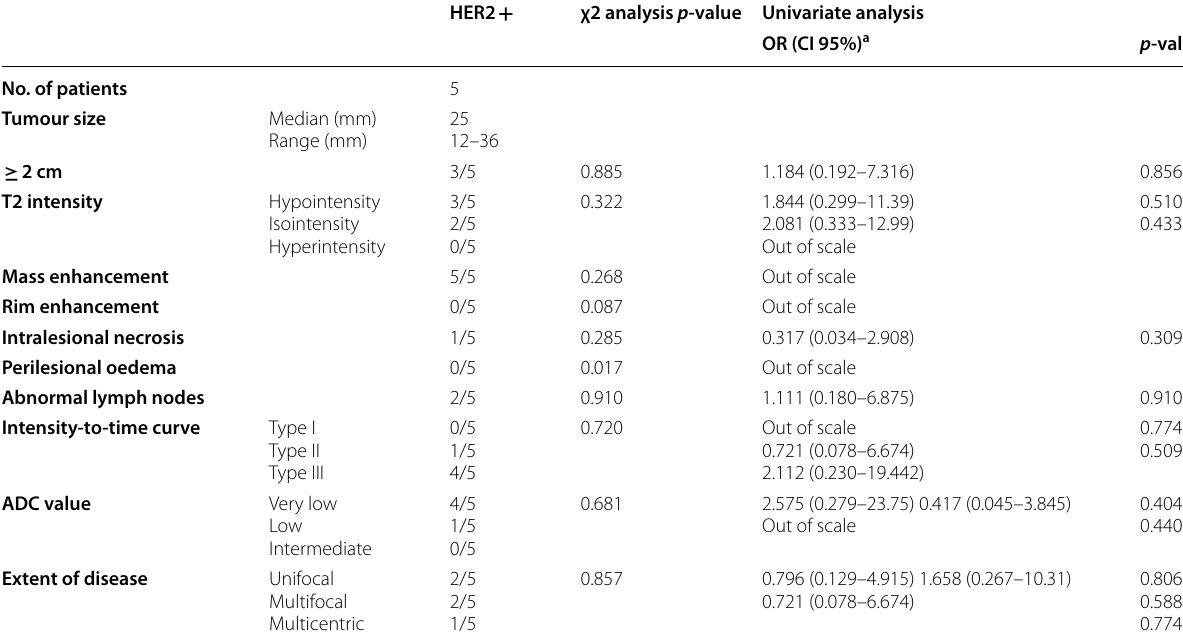
a OR Odds ratio, CI Confidence interval, ADC Apparent diffusion coefficient